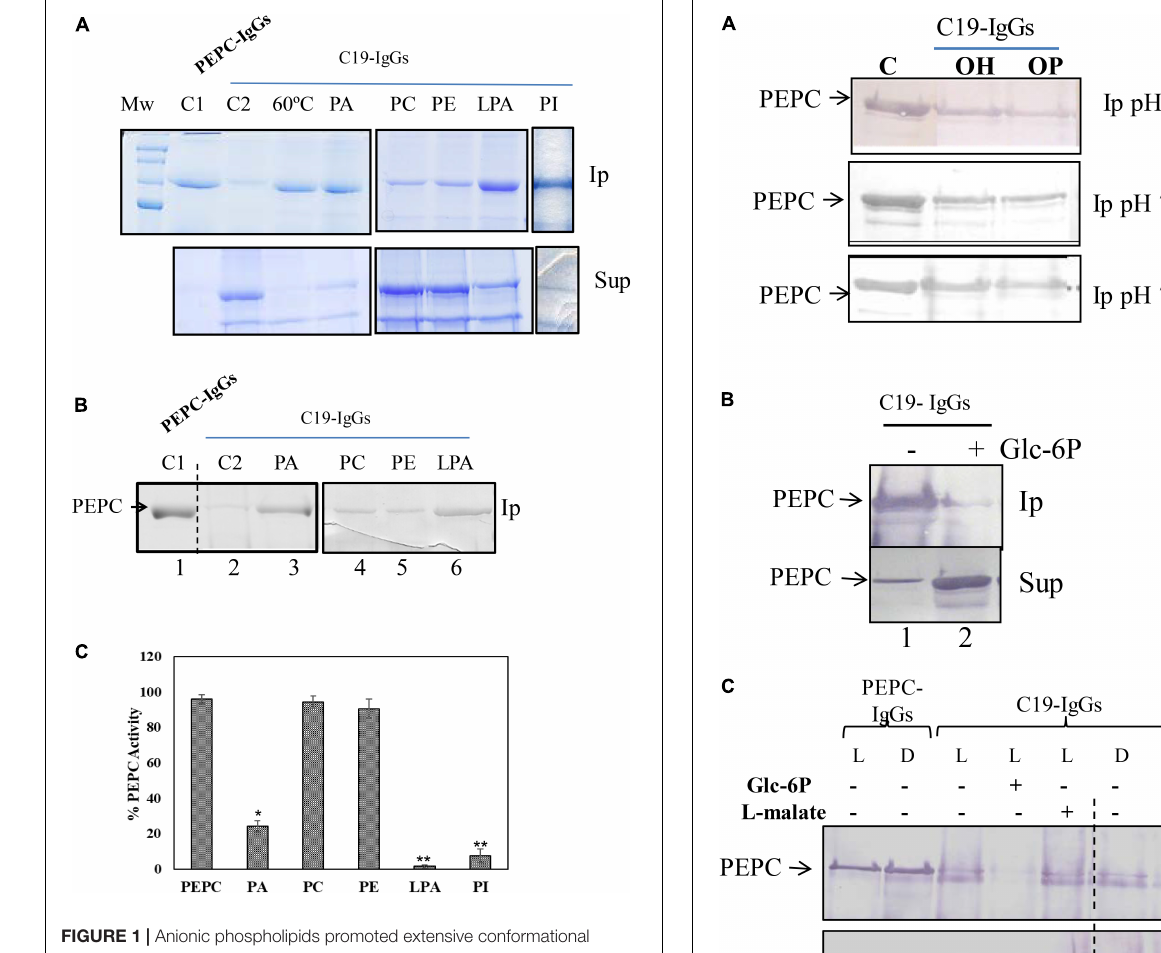
FIGURE 1 | Anionic phospholipids promoted extensive conformational changes in PEPC detected by the exposure of its C -terminus. 0.2 U (A) or 0.1 U (B) of PEPC were incubated in the absence (lanes C1, C2 and 60 ◦ C) or presence of 0.25 mM of the phospholipids indicated (lanes PA, PC, PE, LPA, PI). Following 30 min incubation at 30 ◦ C, PEPC was immunoprecipitated with PEPC-IgG (lane C1) or C19-IgG (remaining samples). An aliquot of PEPC was heated at 60 ◦ C for 2 min to serve as a positive control for C19-IgG (lane 60 ◦ C). This treatment completely exposes the C -terminus of the protein (Alvarez et al., 2003). (A) Immunoprecipitates (Ip) and supernatant (Sup) were analyzed by SDS–PAGE (10%) and stained with Coomassie blue. (B) Immunoprecipitates were immunoblotted with PEPC-IgG. The images in (A) and (B) are representative of at least 3 independent experiments. (C) Effect of the different phospholipids on PEPC activity. PA, phosphatidic acid; PC, phosphatidylcholine; PE, phosphatidylethanolamine; LPA, lyso-PA; PI, phosphatidylinositol4-P. Data represent mean ± SE of 3–6 different experiments. Statistically significant difference with respect controls are indicated by ( ∗ ) at P < 0.05, ( ∗∗ ) at P < 0.01, using the Dunnett test.